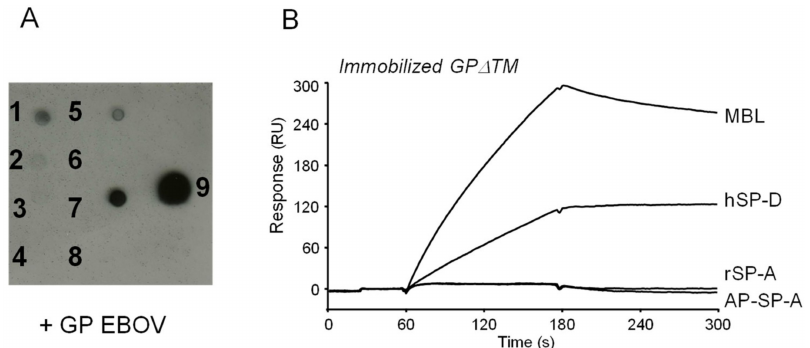
Figure 1. Interaction of hSP-D with the GP of EBOV. ( A ) Binding detection via overlay assay. hSP-D was dotted onto nitrocellulose membranes and incubated with 1 µ g/mL of purified HA-tagged GP ∆ TM. After three washes, bound GP was detected with an anti-HA tag antibody and revealed using enhanced chemiluminescence (ECL). GP ∆ TM (5 ng/spot) and BSA (2 µ g/spot) were dotted as positive and negative controls, respectively. 1, hSP-D; 2, AP-SP-A; 3, rSP-A; 4, ficolin-2; 5, ficolin-1; 6, ficolin-3; 7, MBL; 8, BSA; 9, GP ∆ TM. ( B ) SPR analysis of the interaction of human collectins with immobilized GP ∆ TM of EBOV. Forty microliters of MBL, hSP-D, rSP-A, and AP-SP-A (2 µ g/mL) were injected over 8000 RU of immobilized GP ∆ TM in 20 mM HEPES, 150 mM NaCl, 5 mM CaCl 2 , 0.005% surfactant P20, and pH 7.4. The specific binding signals were obtained by subtracting the background signals over a reference surface with 3600 RU of immobilized fatty-free BSA. The results shown are representative of two independent